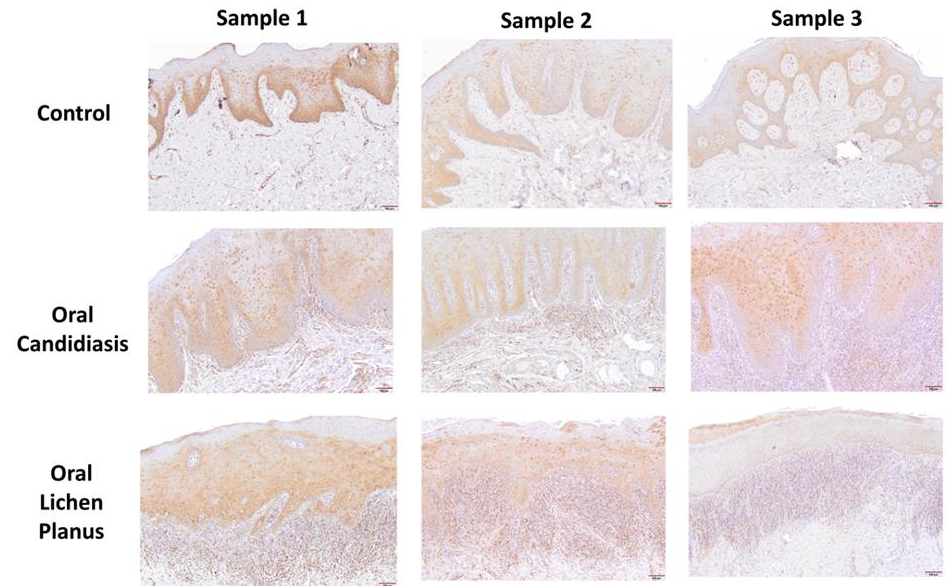
Figure 4. Panels show immunohistochemical staining for Annexin A1 in three tissue specimens from each group of control, oral candidiasis, and oral lichen planus. Each condition displayed nuclear, cytoplasmic and cell membrane staining for Annexin A1, albeit to varying extent as described under Results. Scale bar: 100 μm.